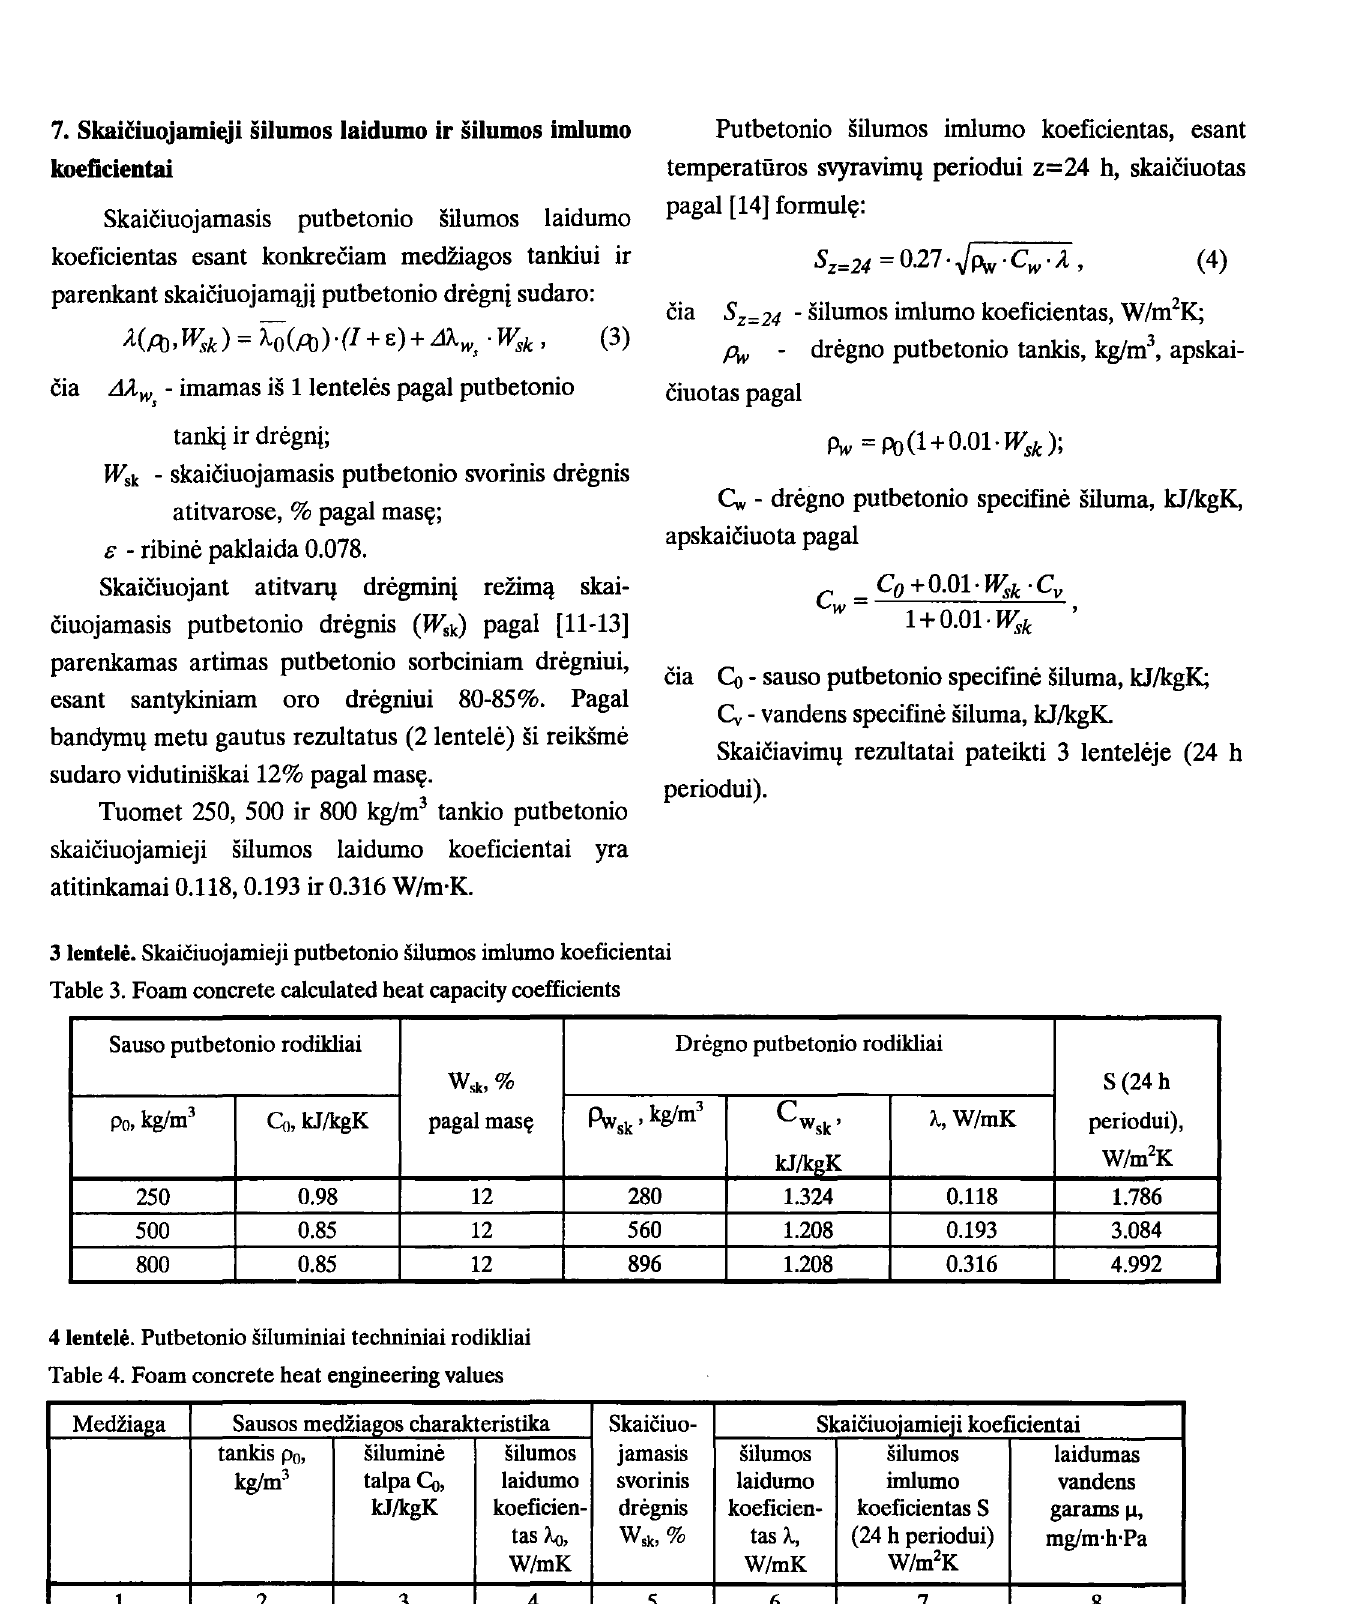
Table 4. Foam concrete heat engineering